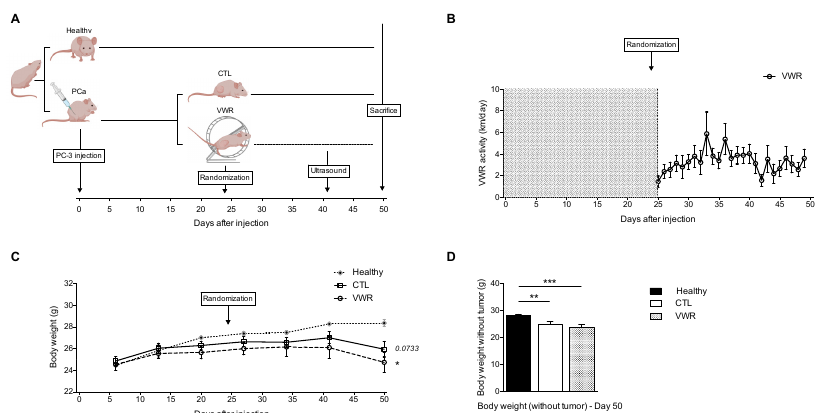
Figure 1. PC-3 xenografts exhibit lower body weight than non-tumor-bearing nude mice and VWR does not counteract this effect. ( A ) Experimental design; ( B ) VWR activity (in km/day) over time; ( C ) Body weight (in g) evolution; ( D ) Body weight after tumor was retrieved (in g) the day mice were euthanized (day 50). Data are represented as means ± SEM. * p < 0.05; ** p < 0.01; *** p < 0.001. We firstly evaluated whether VWR initiated in established tumors was able to mod- ulate tumor perfusion in a PC-3 xenograft model.